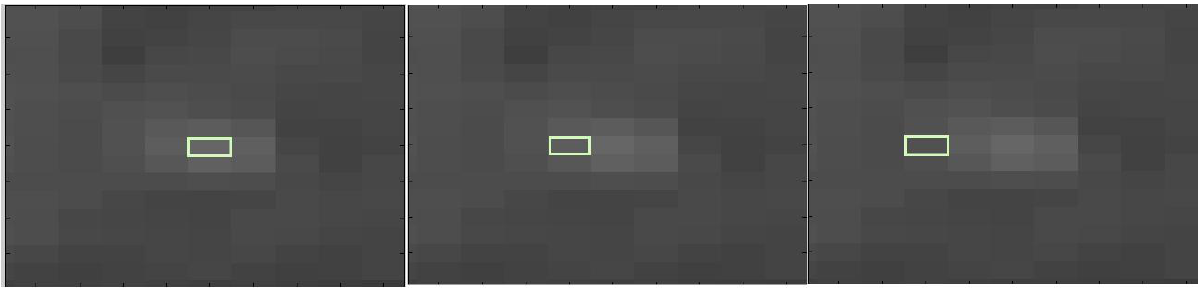
Figure 2. Zoom on the exemplary point in Figure 1. Left: The marked pixel contains the target with the spectrum T as a whole pixel. Center: The marked pixel is a mixed pixel with the spectrum P . Right: The marked pixel is a pure background pixel with the spectrum B .